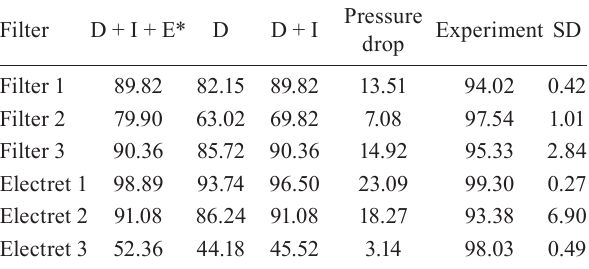
Table 4 Mass filtration efficiencies (%) and pressure drop (Pa) obtained using classic filtration theory correlations and from experiments ( n = 4, SD —standard deviation).